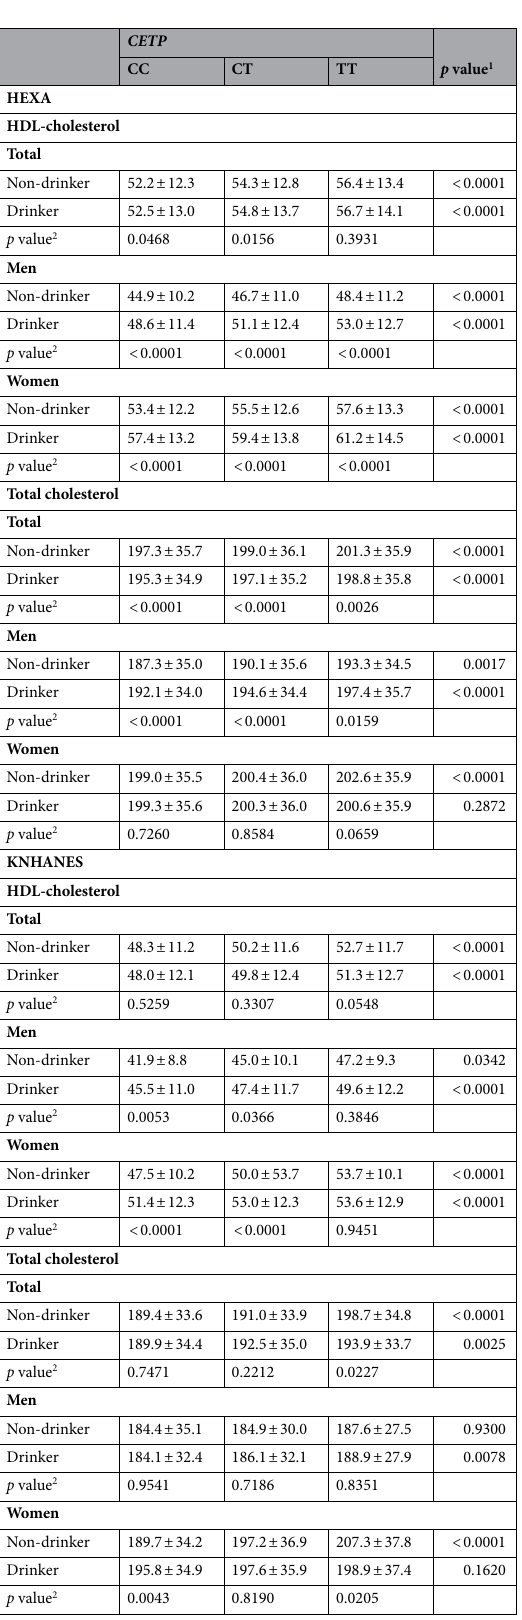
Table 3. Association between alcohol consumption and cholesterol (HDL and total) according to CETP genotype. Data are expressed as means ± standard deviations. 1 General linear models were used to assess differences in variables between CETP genotype. 2 Student’s t-test was used to assess difference in a variable between alcohol consumption in each CETP